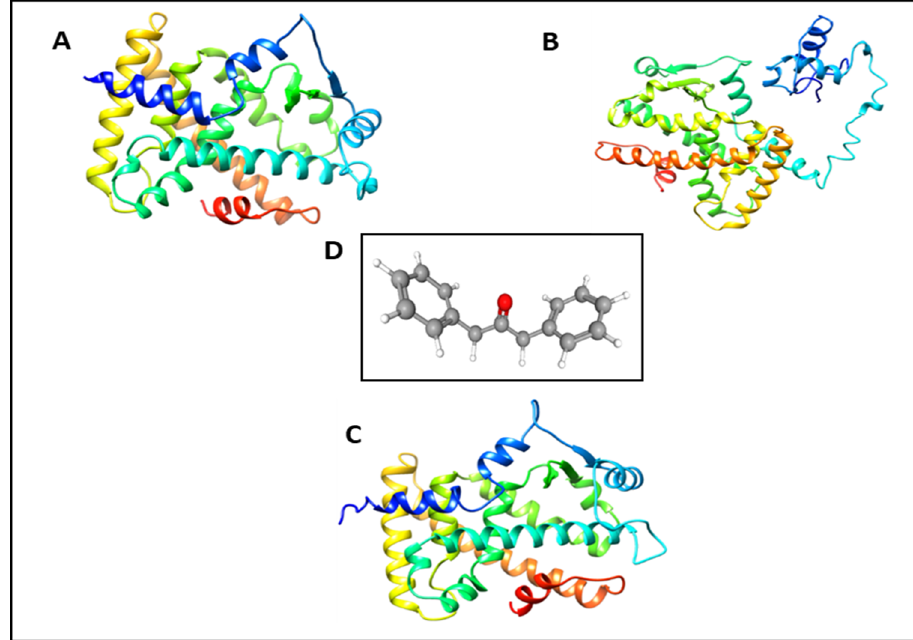
Figure 2. Crystalline structure of receptor ( A ) PPAR γ -3DZY ( B ) PPAR α -1k7l A ( C ) PPAR β -1GWX A http://rcsb.org (accessed on 27 September 2019) ( D ) Optimized structure of small compound 1,3-Diphenyl-2-propanone. Table 5. The binding energy and interacting residues obtained by calculating the PPAR α –DPP molecular docking scores. Binding Energy Inhibition Constant Compound (kcal/mol) 1,3-Diphenyl-2- propanone